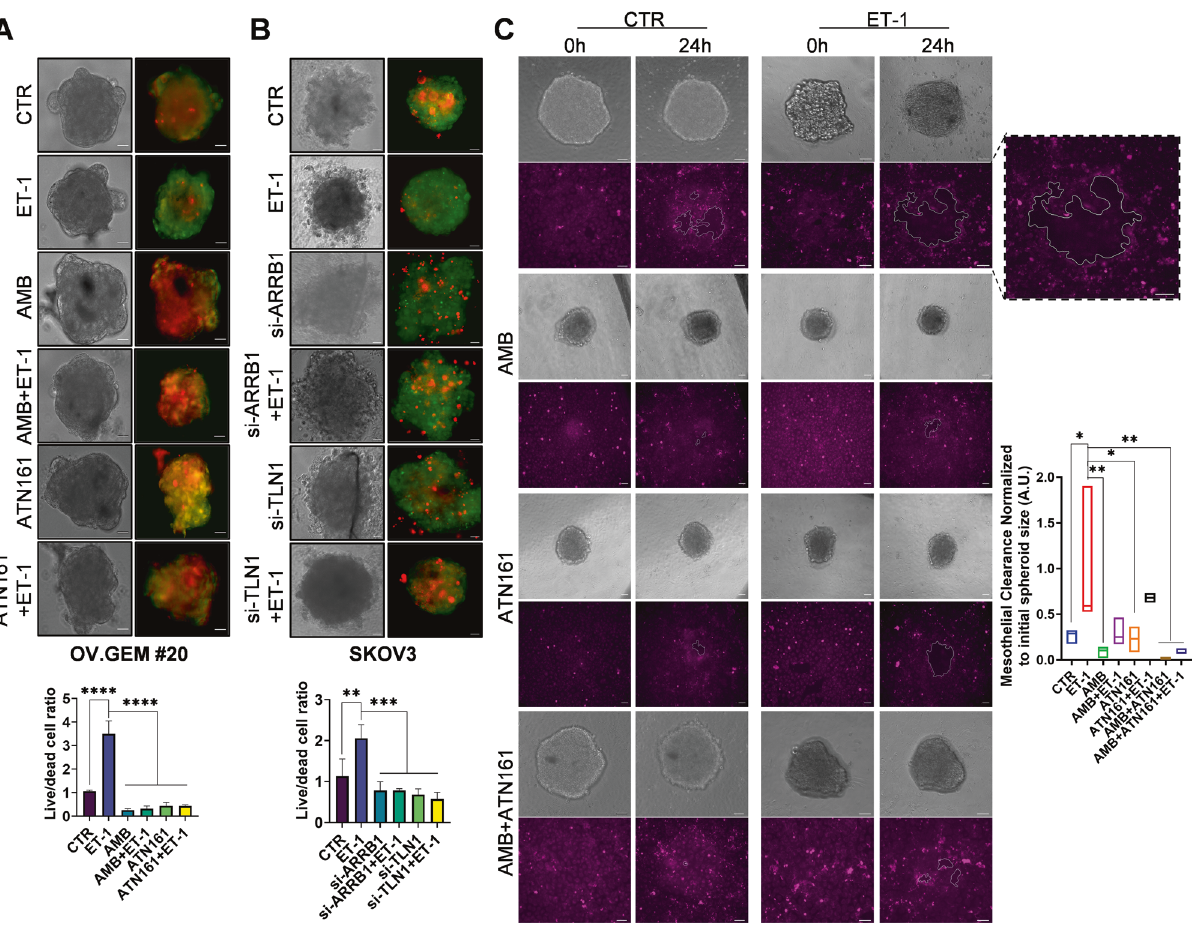
(green) or dead (red) cells were determined using a dual- fl uorescence system. Histograms mean ± SD of the live/dead cell ratio (fold changes versus CTR); n = 2, one-way ANOVA. C Images depict mesothelial clearance induced by SKOV3 spheroids treated with ET-1 and/or AMB + ATN161 at 0- and 24-h time points. Scale bar, 50 μ m. The graph represents the ratio between the area of the “ hole ” /aperture in the mesothelial monolayer after 24 h (highlighted with the white line) and the initial spheroid area (0 h). n = 2, one-way